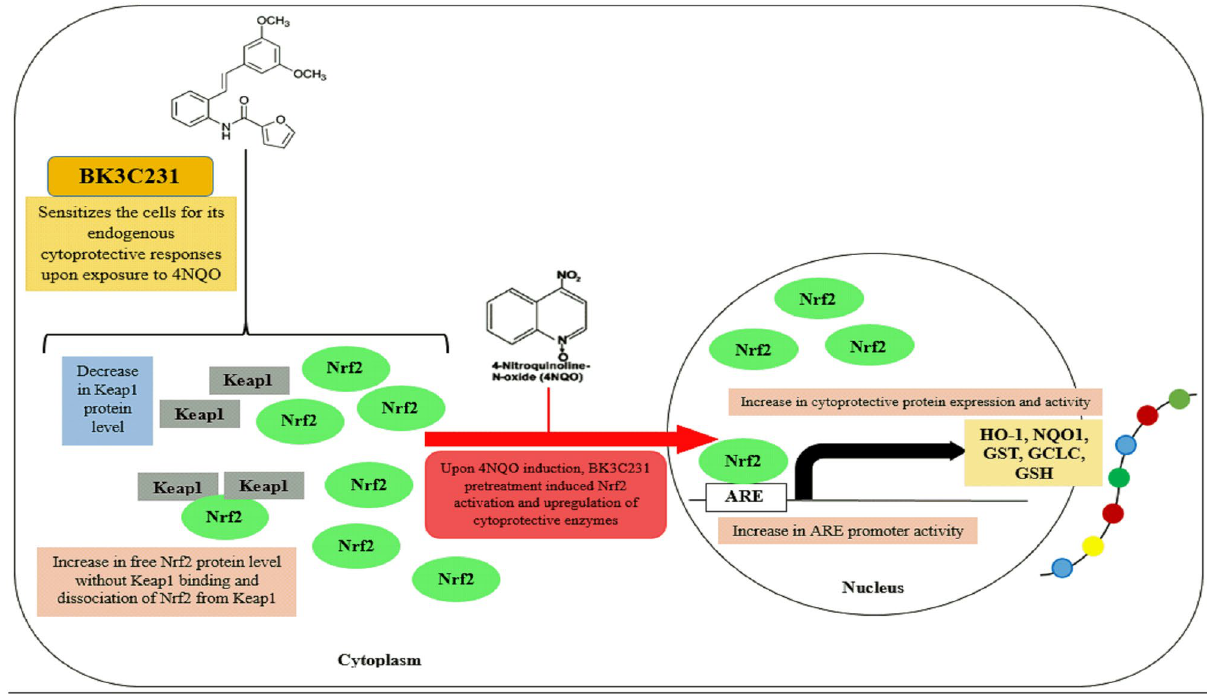
Figure 5. Schematic illustration representing the cytoprotective effects of BK3C231 through Nrf2 activation which leads to ARE-mediated upregulation of cytoprotecive enzymes. Upon exposure of cells to 4NQO, BK3C231 pretreatment increased protein expression and activity of the cytoprotective enzymes namely NQO1, GST and HO-1, as well as maintaining GCLC at basal level. BK3C231 pretreatment prior to 4NQO exposure induced Nrf2 activation by increasing Nrf2 protein level and decreasing Keap1 level, as well as promoting disruption of Keap1-Nrf2 complex thus leading to an increase in ARE promoter activity upon Nrf2 activation and upregulation of cytoprotective enzymes. Interestingly, reduction in Keap1 level which lead to an increase in the dissociation level of Nrf2 from Keap1 as well as ARE promoter activity were observed in cells treated only with BK3C231, hereby suggesting that BK3C231 is able to sensitize the cells for its endogenous cytoprotective responses and elevate the cytoprotective capacity of cells upon exposure to stress inducers or toxicants such as